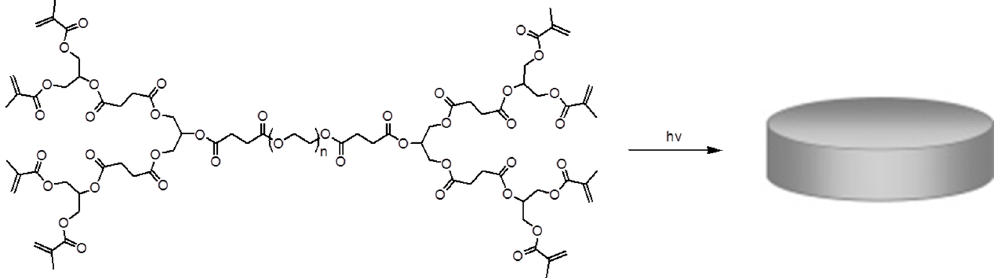
Figure 11. Photo-crosslinkable methacrylated generation 3 (G3) dendrimer PEG ester conjugate. Adapted with permission from [36], Copyright 2006 American Chemical Society.